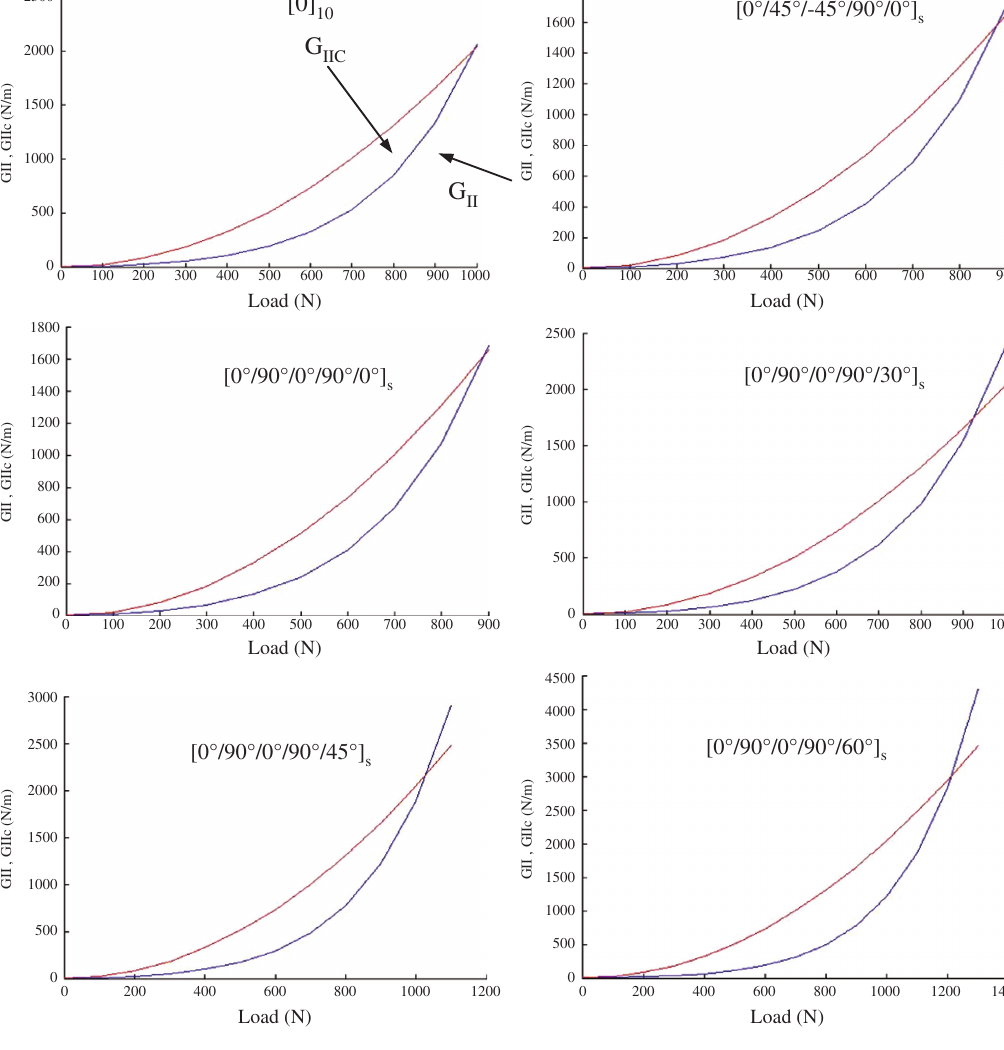
Figure 3 Energy release rate-load diagram for e-glass/epoxy obtained from meshfree